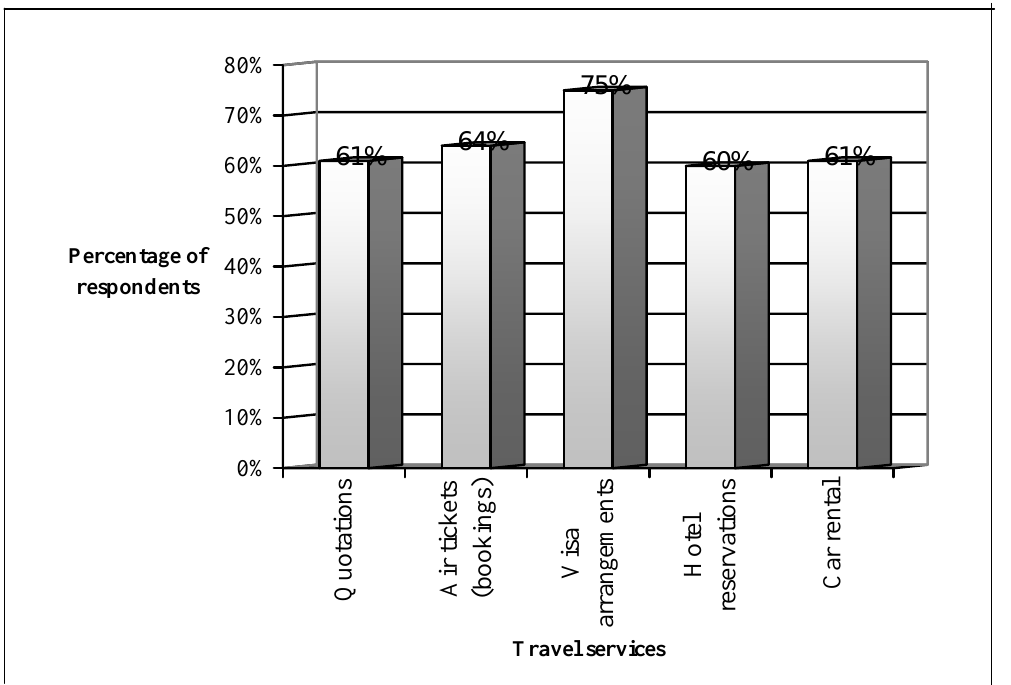
Services to be included in a service fee